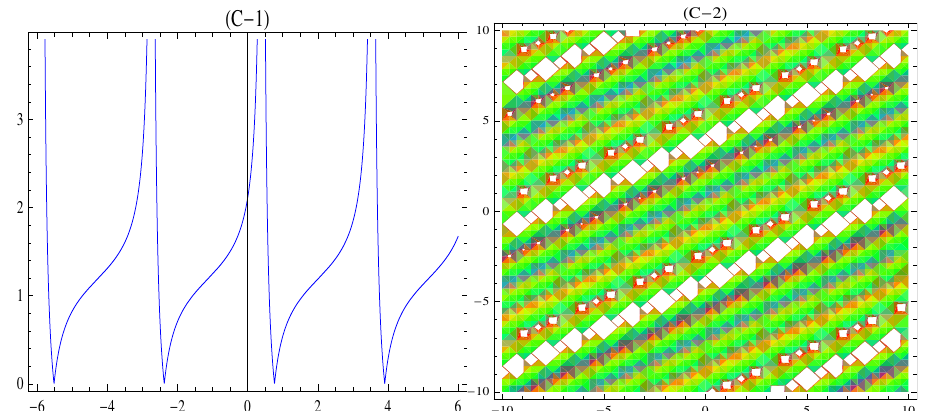
Figure 3. ( C ) 3D graph of periodic–singular of (37) with l = 2.2, m = 0.3, µ = 0.7, g = 0.7, ζ = 0.5, V = 0.3. ( C-1 ) 2D plot and ( C-2 ) contour plot of (37).